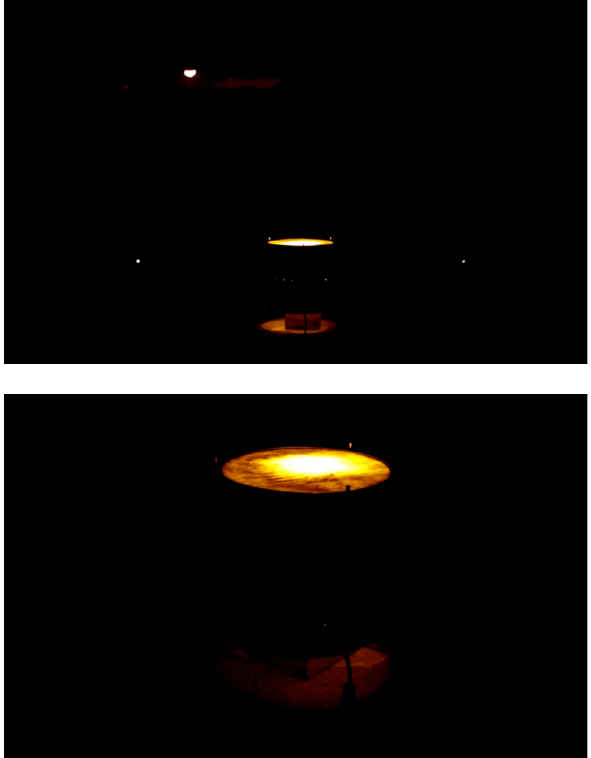
Figure 3 | Control and Unpredictability sound